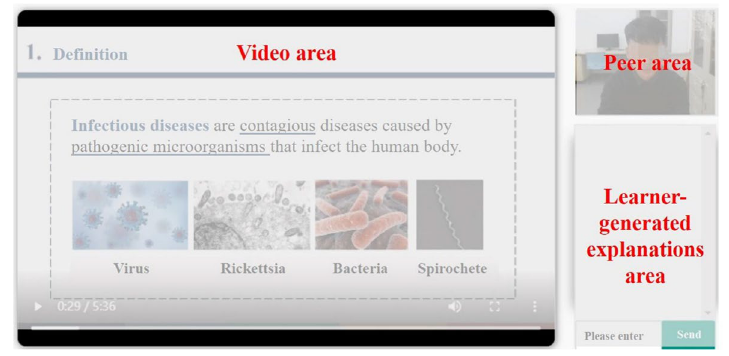
Fig. 1 The three areas of the screen (translated from Chinese)